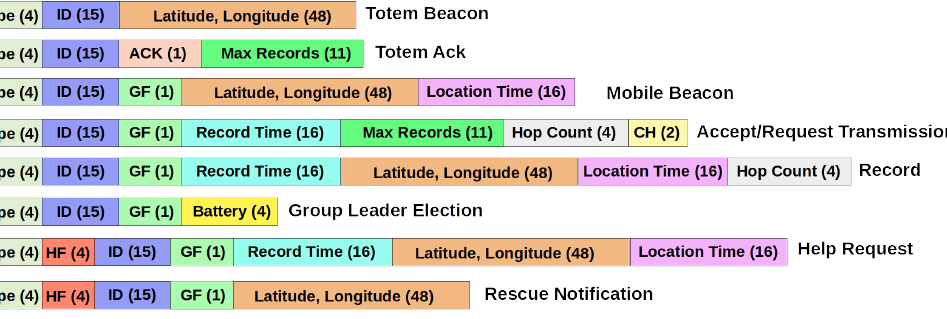
Figure 9. Message types and